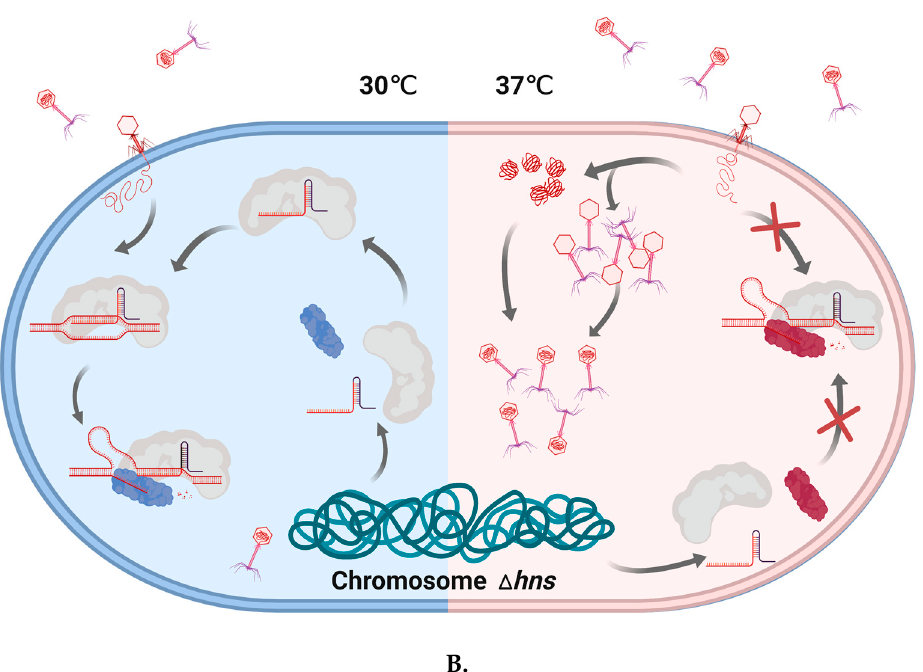
Figure 3. Temperature-dependent Cas3 / CRISPR functions in E. coli and the E. coli ∆ hns strain. A. Cas3 stimulates uncontrolled ColE1 plasmid replication in a temperature-dependent manner. ColE1 plasmid yield was stimulated by Cas3 in cells at 37 ◦ C but not at 30 ◦ C. This requires a functional helicase domain. We speculate that this phenomenon may indicate a possible change in Cas3 conformational ‘state’, illustrated by coloring Cas3 in blue ‘demotivated’ or red ‘motivated’. At 37 ◦ C, ‘motivated’ Cas3 may interact with R-loop formation in ori by dissociating RNA II from the complementary strand, and lead to increased plasmid replication in vitro. B. Temperature impacts CRISPR function in E. coli cells lacking H-NS. This ∆ hns strain at 30 ◦ C can defend against invader DNA during phage infection, even though Cas3 is in ‘unmotivated’ state. However, ∆ hns strain cannot survive under infection pressure at 37 ◦